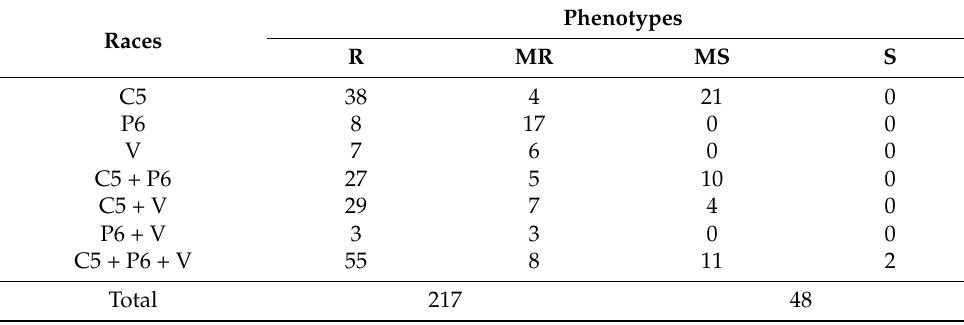
Table 1. Phenotypic disease response of 265 RILs against different BB races of rice considering single and multiple races together.